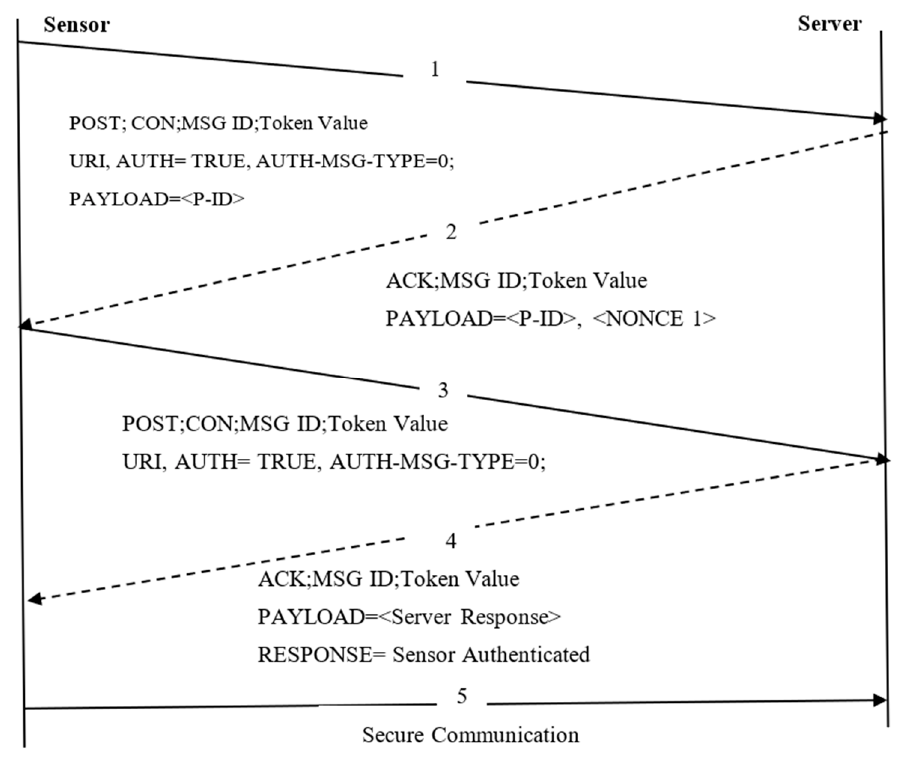
Figure 4. Two-way authentication scheme using payload encryption.